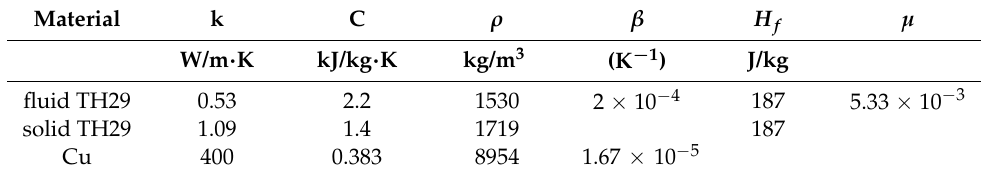
Table 2. Material thermo-physical properties